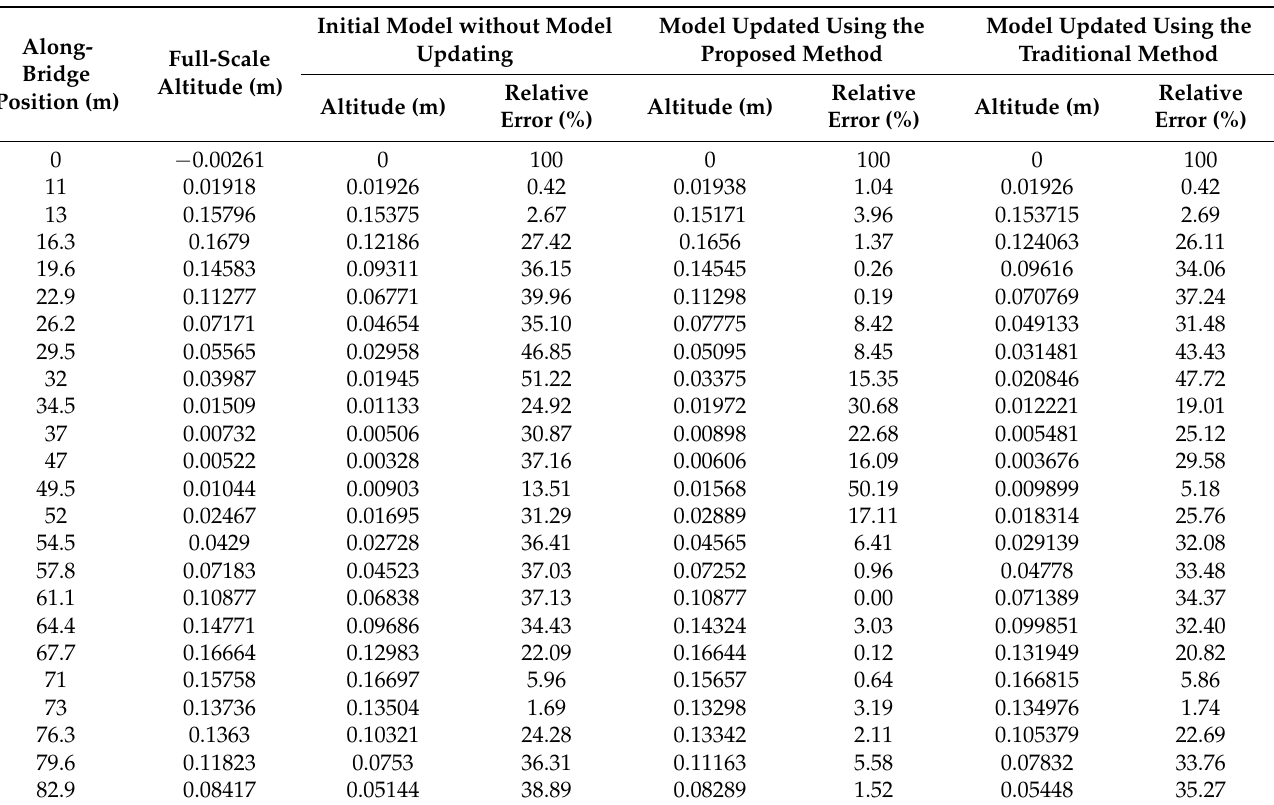
Table 3. Along-bridge altitudes of Huangsha Harbor Bridge measured on location and calculated using the FE